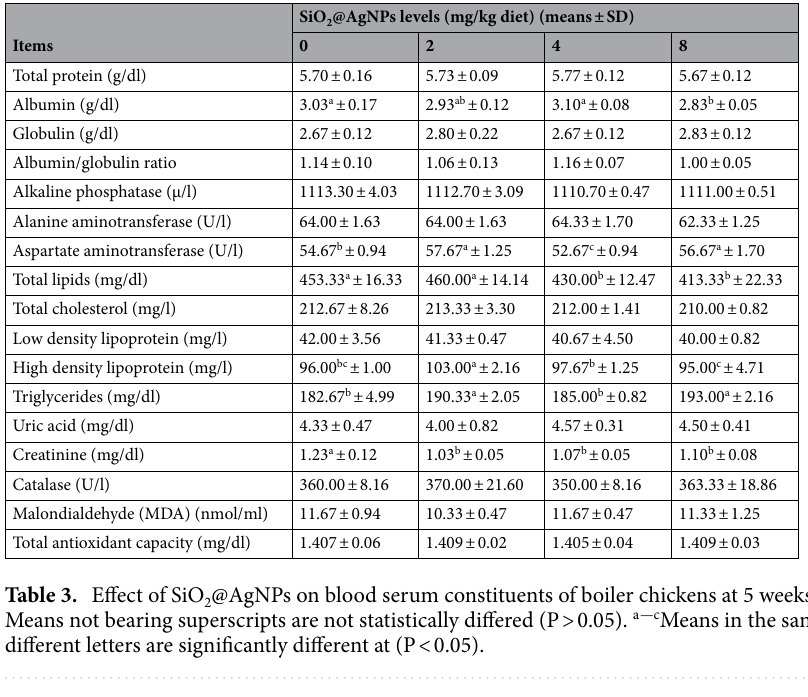
(Fig. 3J). In addition, the second (4 mg) treatment group showed few lymphoid follicles (Fig. 3K), whereas the third (8 mg) treatment group showed a complete absence of lymphoid follicles (Fig. 3L).